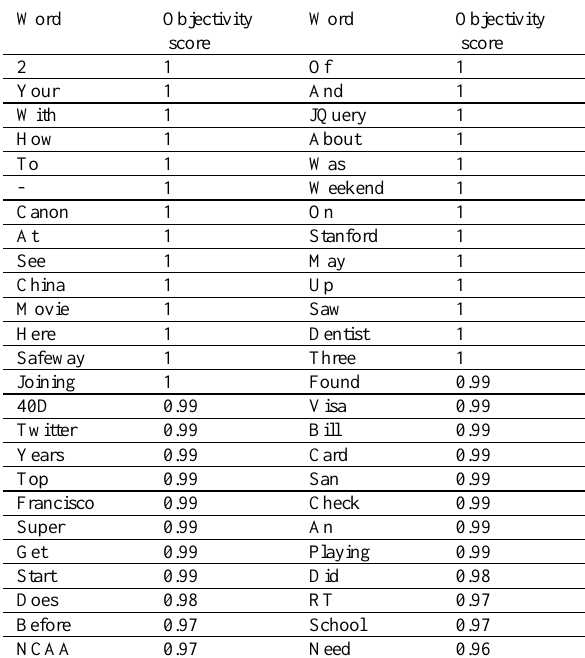
Table 5. The most objective words based on objectivity score.